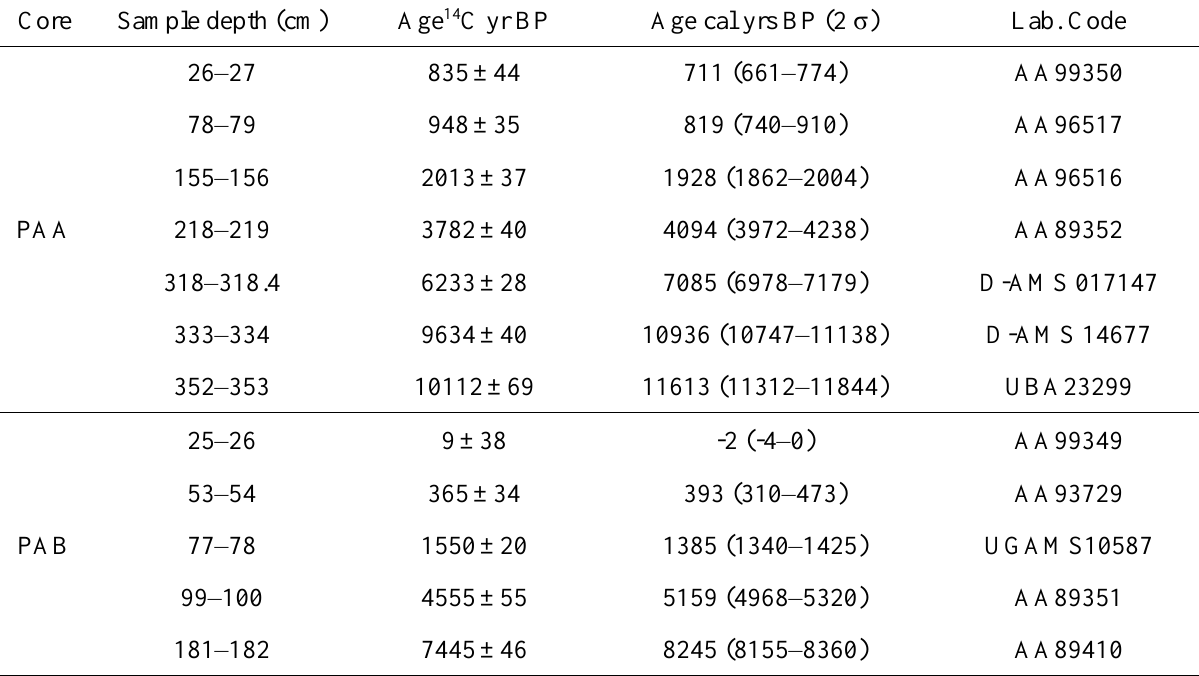
Table 1. Radiocarbon ages for the PAA and PAB peat sequences. The material analysed was bulk organic matter.